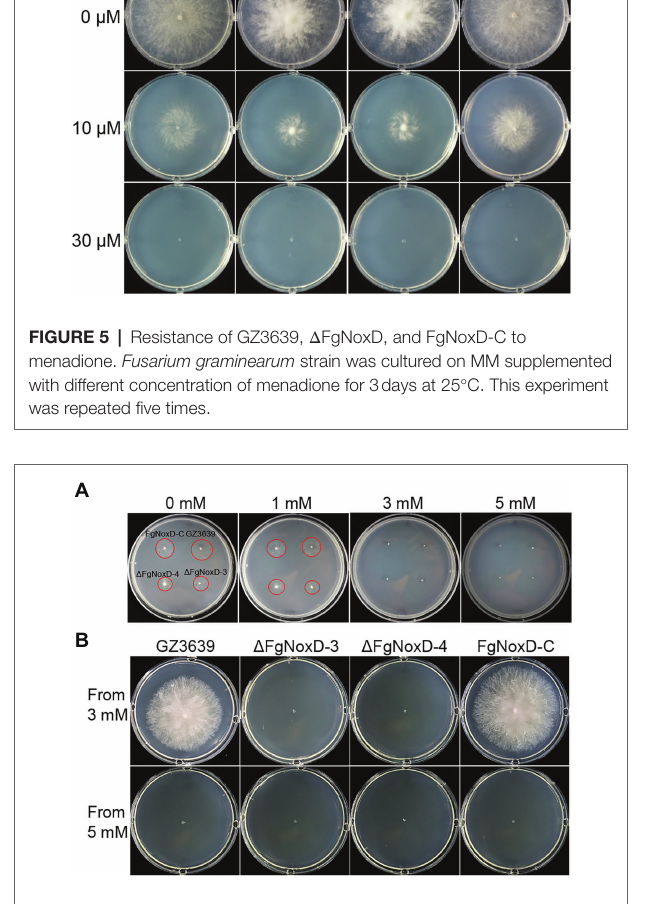
FIGURE 6 | The effect of H 2 O 2 on survival of GZ3639, Δ FgNoxD, and FgNoxD-C. (A) All strains were cultured in MM supplemented with different H 2 O 2 concentrations for 1 day. (B) Strains from media containing 3 or 5 mM H 2 O 2 were cultured for 3 days. The red circles indicate areas of growing mycelium.